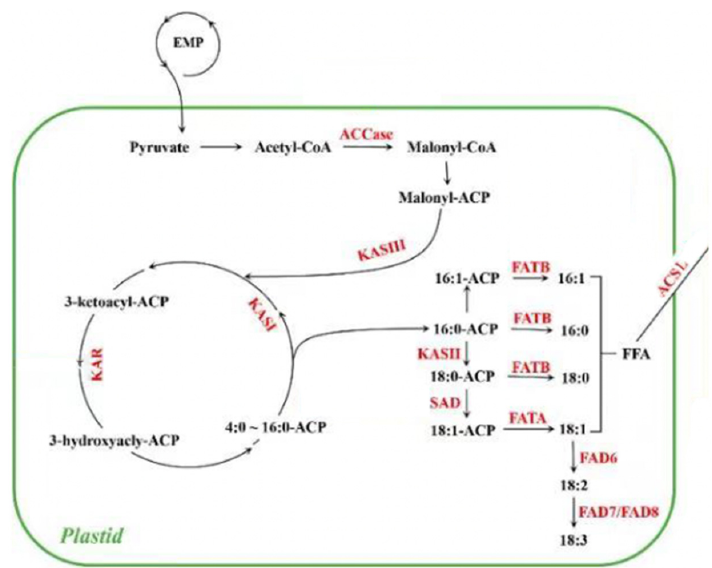
Figure 10. FA biosynthesis pathway.